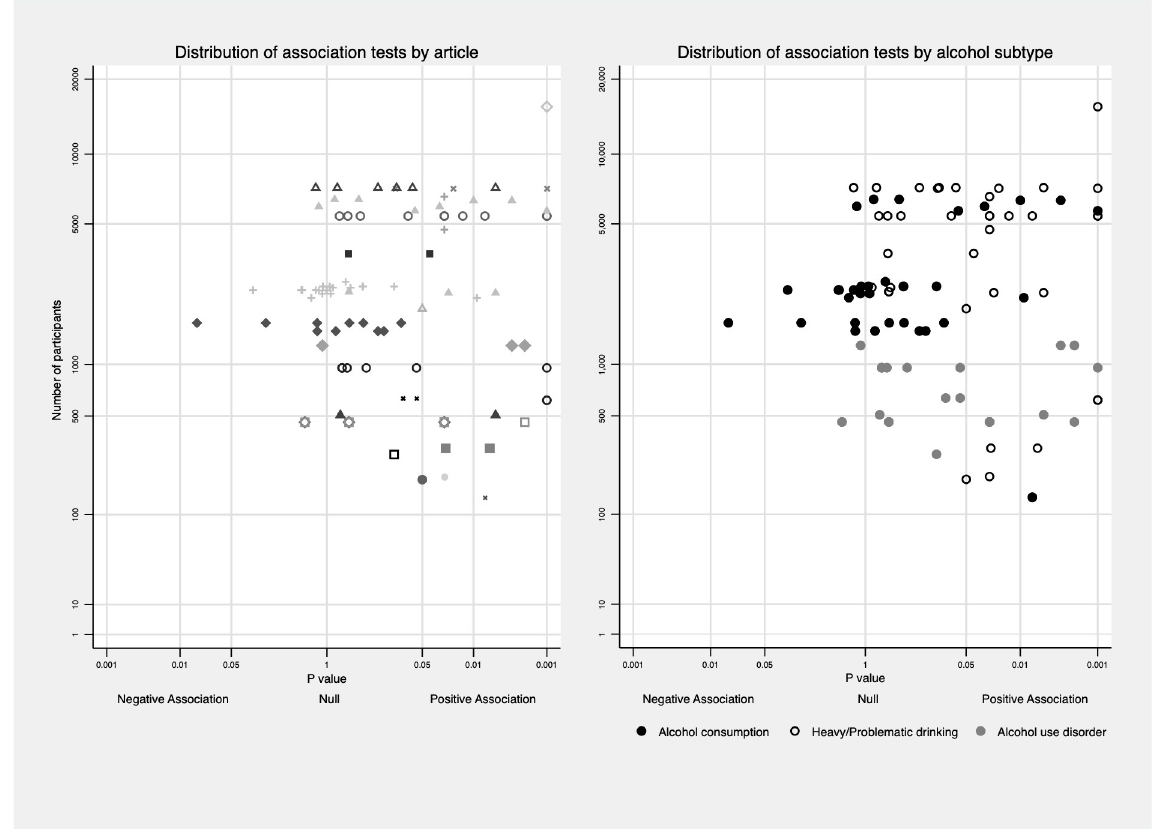
Fig 2. Distribution of association tests between EXT and subtypes of alcohol use behaviours. Distribution of association tests clustering in one article was plotted on the left to show the non-independence among tests.